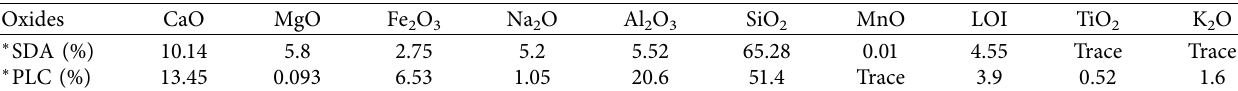
Table 5: Chemical properties of cement (PLC) and SDA.